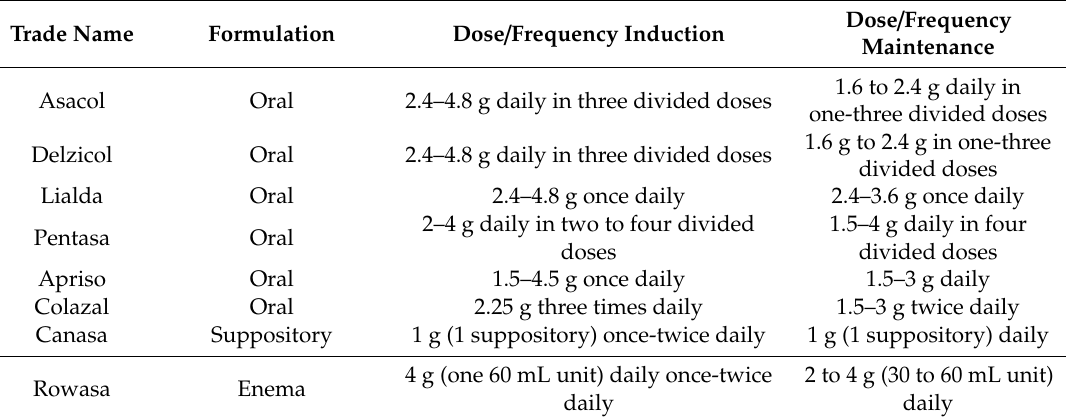
Table 1. Mesalamine